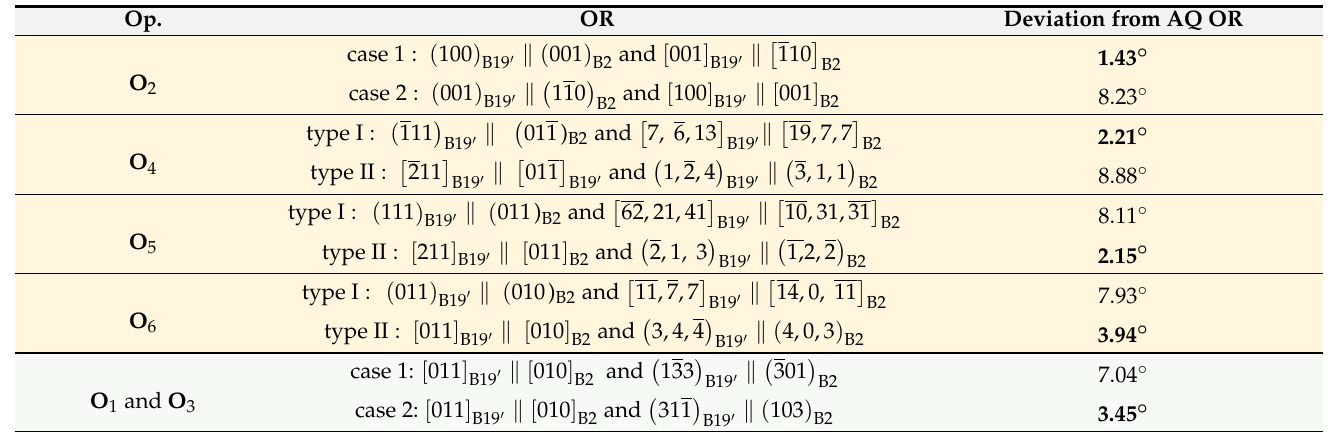
Table 4. Closing-gap ORs between two B19 (cid:48) variants linked by the operator O i predicted by the correspondence theory. In the last column are the deviation angles between the closing-gap OR and the natural OR AQ [24]. For each operator, the minimum angle is written in bold. Op.